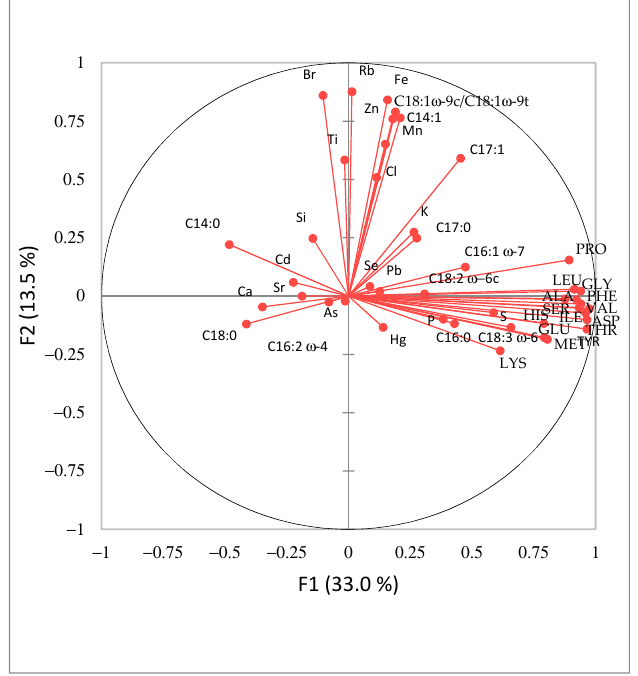
Figure 4. Principle Component Analysis variable loading plot for Spirulina dietary supplements ( n = 47) available in Slovenia.